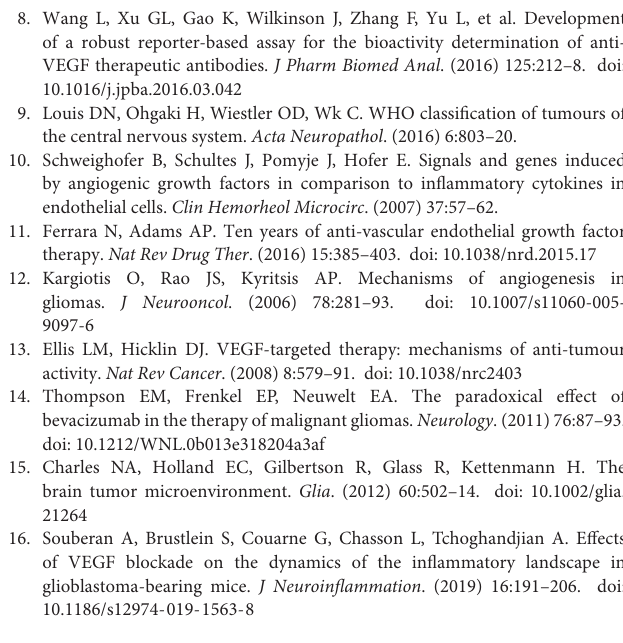
tandem repeat of the Gal4 upstream activation sequence (UAS) resulting in activation of the firefly luciferase reporter-gene. FIGURE S2 | The stability of the VEGF responsive reporter-gene cell line was determined by testing VEGFA induced FL activity at regular intervals for 20 passages by incubating the VEGF responsive reporter-gene cells for 18 h with increasing concentrations of VEGFA prior to quantification of FL activity as described in the section “Materials and Methods”. FIGURE S3 | Inter and intra-assay precision was determined by incubating increasing concentrations of bevacizumab with 4 individual samples of VEGFA at a final concentration of 25 ng/ml for 30 min at room temperature on a single microtiter plate (A) or with a single sample of VEGFA at a final concentration of 25 ng/ml and incubated for 30 min at room temperature on 4 individual microtiter plates (B) prior to incubation for 18 h at 37 ◦ C with the VEGF responsive reporter-gene cell line and quantification of FL activity as described in the section “Materials and Methods.” The associated Table to Figure 2 shows the principal parameters of a 4PL plot determined using the Prism software together with intra-plate or inter-plate percentage coefficients of variation (% CV). FIGURE S4 | The accuracy and linearity of the reporter-gene assay was determined by incubating concentrations bevacizumab corresponding to 25, 50, 100, 125, and 150% of the expected value with VEGFA at a final concentration of 25 ng/ml for 30 min at room temperature prior to incubation for 18 h at 37 ◦ C with the VEGF responsive reporter-gene cell line and quantification of FL activity as described in the section “Materials and Methods”. FIGURE S5 | Increasing concentrations of bevacizumab were mixed with 25 ng/ml of VEGFA for 30 min at room temperature prior to incubation for 18 h with VEGF responsive reporter-gene cells either alone or in the presence of 2.5, 5, or 10% normal human serum and quantification of FL activity as described in the section “Materials and Methods” (B) . The associated Table to Figure 1 shows the principal parameters of a 4PL plot determined using the Prism software. FIGURE S6 | ADCC effector cells (E) at a concentration of (1.2 × 10 5 cells/well), were incubated with human U87 glioblastoma target cells (T) at an E:T ratio of 3:1 and 100 µ g/ml of bevacizumab or 100 µ g/ml of inflixumab for 4 h prior to the quantification of ADCC activity as described in the section “Materials and Methods”. TABLE S1 | Patients with ovarian cancer: Treatment schedule ∗